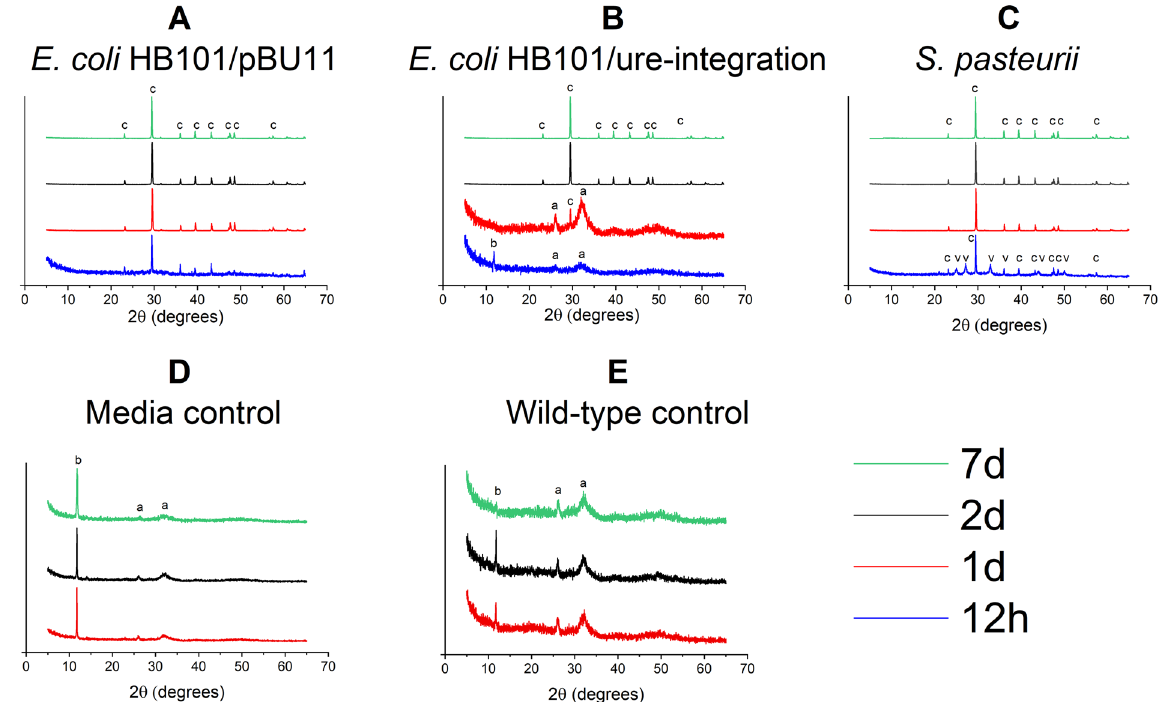
Figure 2. XRD detection of CaCO 3 and CaP precipitated by ureolytic and control cultures throughout 7d. ( A ) E. coli HB101/pBU11 precipitated only calcite at all time points. ( B ) E. coli HB101/ure-integration initially precipitated brushite and apatite. At 1d, the dominant calcite peak emerged. At 2–7d, only calcite was detected. ( C ) S. pasteurii precipitated vaterite (v) and calcite (c) at 12h, and only calcite at later timepoints. ( D ) For all time points, the Media Control culture precipitated calcium phosphate phases, including brushite (b) and apatite (a). No CaCO 3 was detected. ( E ) The Wild-Type Control precipitated calcium phosphate phases, but not CaCO